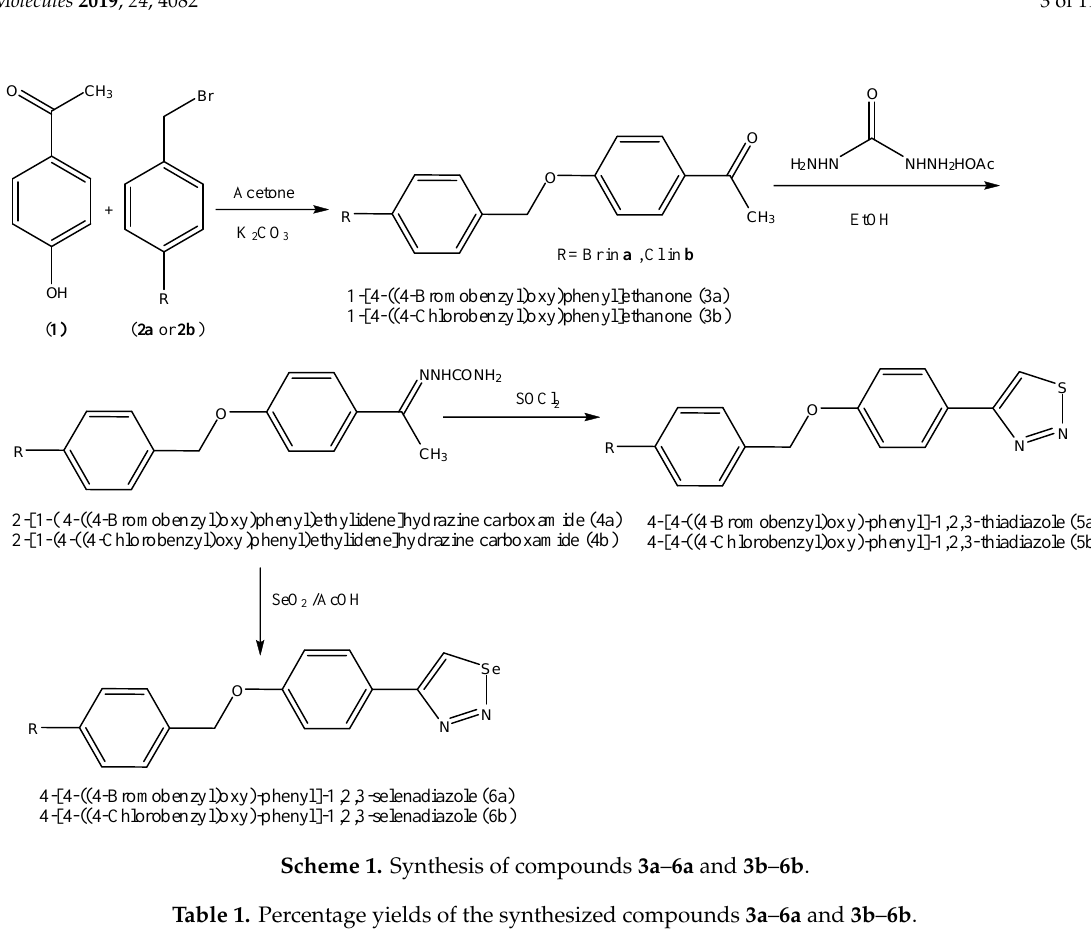
Table 2. Sensitivity of human pathogenic microbes to the new synthetic heterocyclic compounds using the hole method.